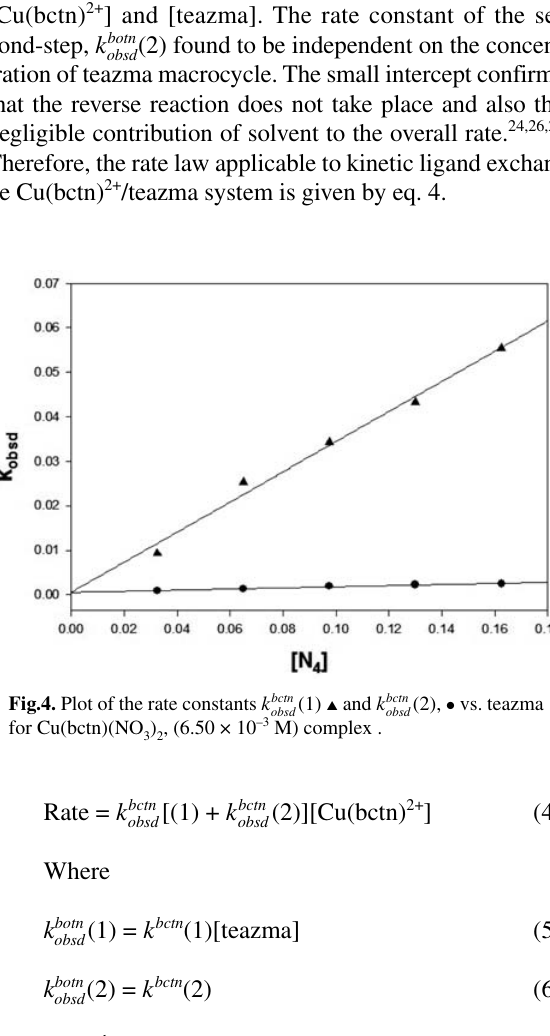
Fig. 3. Plot of absorbance vs. time for reaction of Cu(bctn)(NO (6.50 × 10 –3 M) and teazma, a = 6.50 × 10 –3 M, b = 6.50 × 10 –2 M, c = 1.63 × 10 –1 M recorded in DMF solvent.